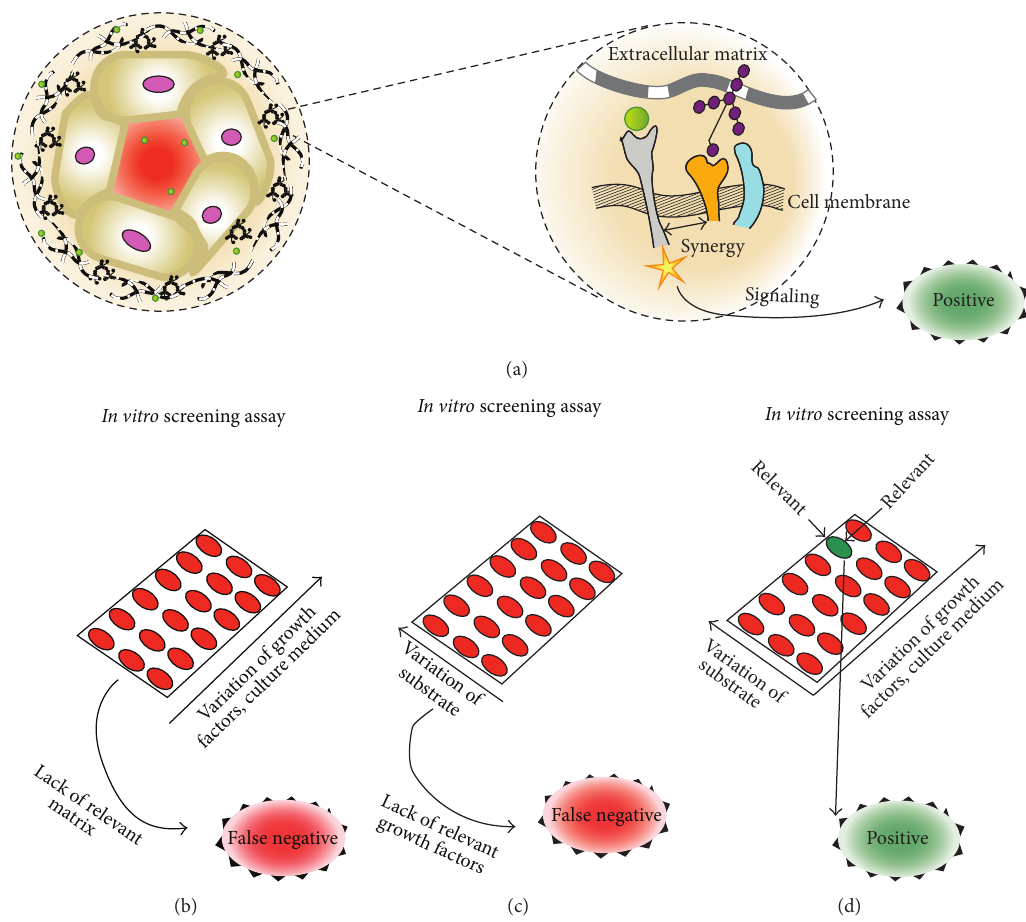
Figure 4: Biological relevance as a key to developing functional in vitro culture systems . There is a need for developing advanced, highly functional, robust, and long-term lasting in vitro culture systems for cells and organoids. In order to identify biologically active scaffolds, adhesion epitopes, and growth factors, high-throughput array approach is often used. It allows unbiased screening of large libraries of soluble compounds (proteins, peptides, and inorganic substances), as well as libraries of matrix scaffolds. However, sometimes biologically active compounds show false negative result, if the other aspects of the system are not biologically relevant. (a) The natural niche of a specific cell type can often serve a prototype for developing a highly functional in vitro culture system. Synergy of biologically relevant extracellular matrix cues and growth factors may be required in order to enable well-regulated cell function. (b) When a library of growth factors is analyzed in cell-based high-throughput screening array, the highly biologically active compounds may be identified as “false negatives” if the adhesive scaffold is not biologically relevant and does not enable co-signaling. (c) Also, if a library of scaffolds, whether natural, artificial, or mixed, is analyzed in cell-based high-throughput screening array, the truly functional scaffold may fail to provide the desired effect, if the cell culture medium lacks biologically relevant soluble factors that take part in co-signaling. (d) It is advisable, therefore, to arrange the high-throughput screening assays that would screen for a combination of growth factors library versus a scaffold library. The positive hit that can be missed in single-library screening may be identified in double-library cross-screening